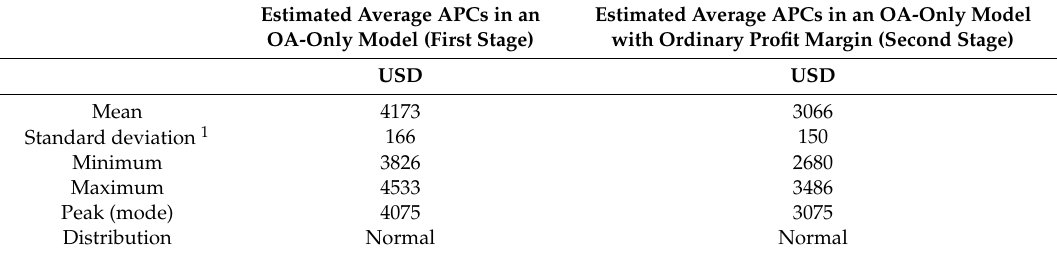
Table 6. Results: comparison of current and estimated average APCs (based on 2018